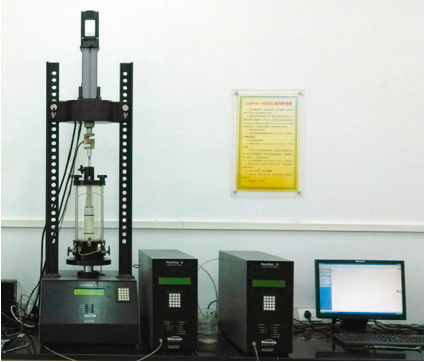
Figure 8: Geocomp triaxial